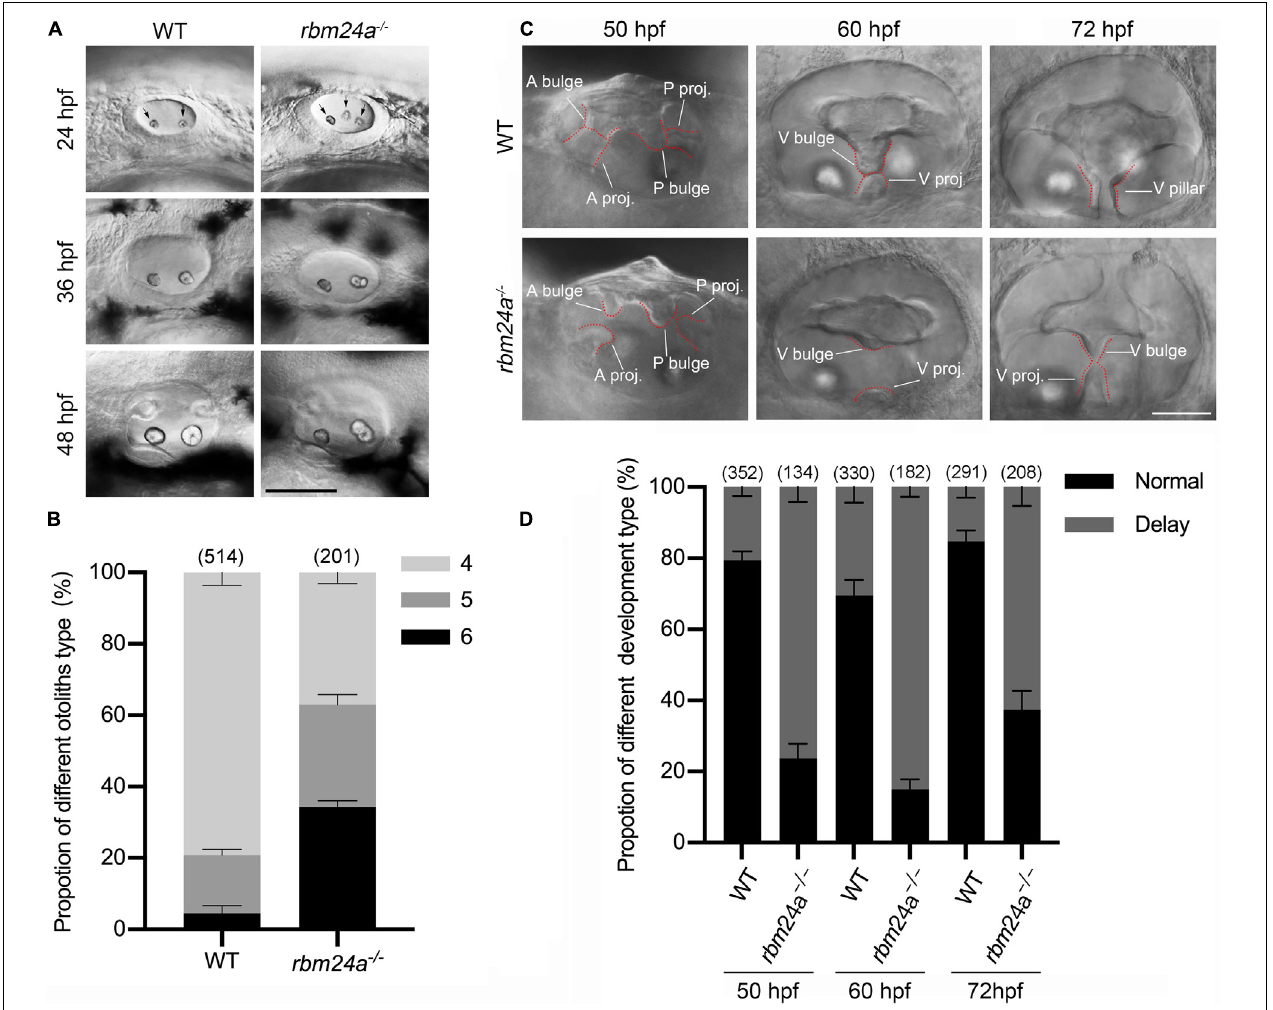
FIGURE 3 | Otolith formation and semicircular canal fusion are delayed in rbm24a mutants. (A) Otolith formation in zebrafish larvae is examined using a light microscope at 24, 36, and 48 hpf as indicated. Otoliths are indicated with arrows. Scale bar, 0.1 mm. (B) The numbers of otic vesicles per larvae at 24 hpf are calculated according to the results from (A) . P values are 0.000833 (larvae with 4 otoliths), 0.020678 (larvae with 5 otoliths), and 0.00044 (larvae with 6 otoliths). (C) Fusion of the semicircular canals is examined using a light microscope at 50, 60, and 72 hpf as indicated. Scale bar, 50 µ m. (D) The numbers of larvae with normal or delayed semicircular canal fusion are calculated according to the results from (C) . P values are 0.000001 (50 hpf), 0.00005 (60 hpf), and 0.000034 (72 hpf). The numbers of larvae for each genotype are indicated in brackets. A bulge, anterior bulge; A proj., anterior projection; P bulge, posterior bulge; P proj., posterior projection; V bulge, ventral bulge; V proj., ventral projection; and V pillar, ventral